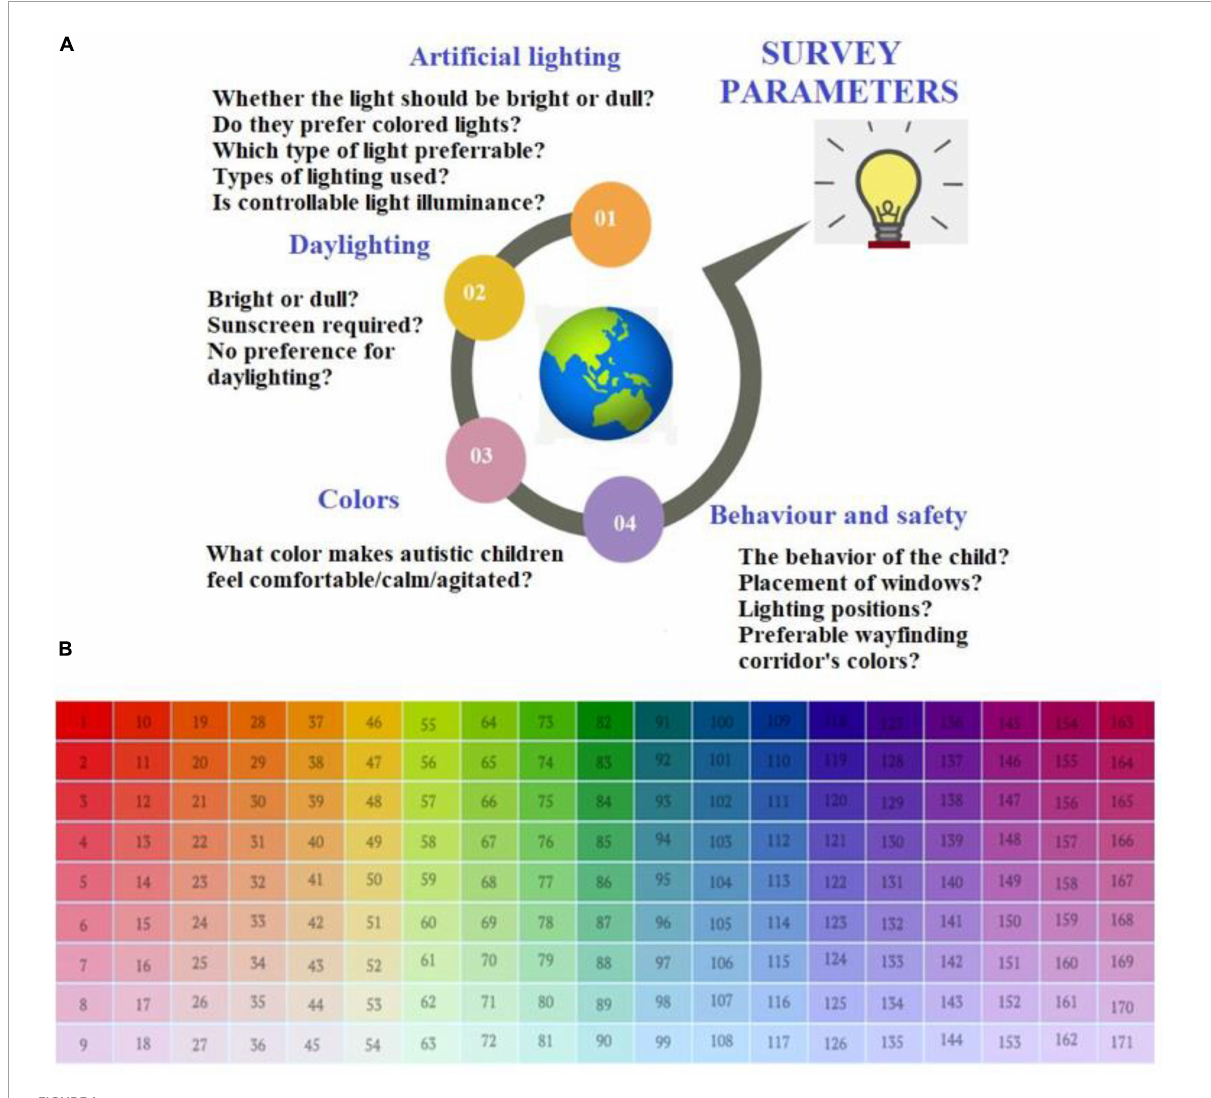
FIGURE1 (A) Parameters used for framing the questionnaire of the present study, (B) color matrix prepared to understand user preferences and